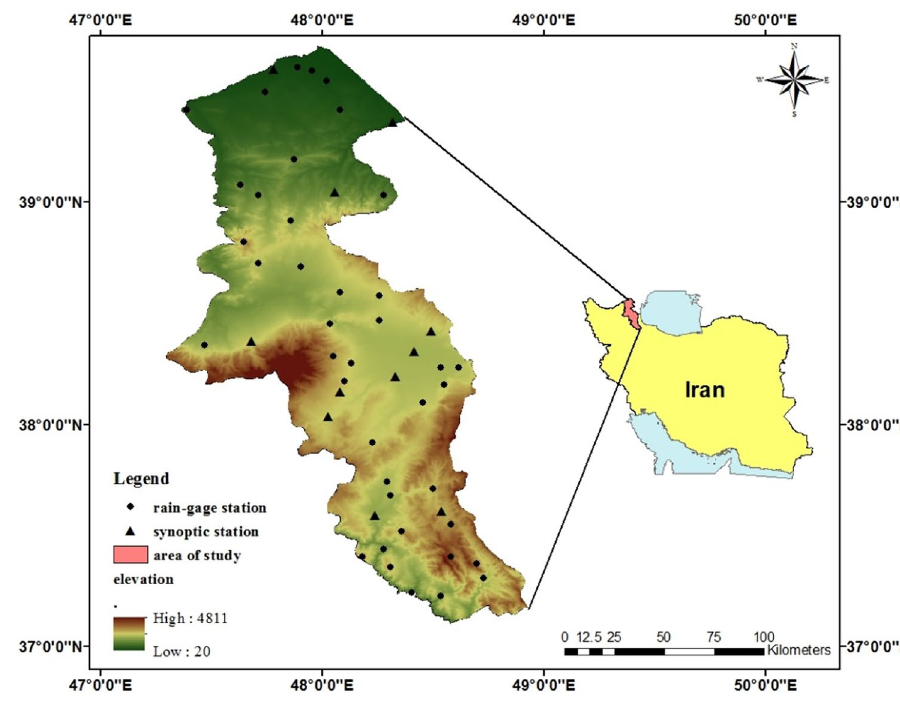
Fig.1 Distribution of studied